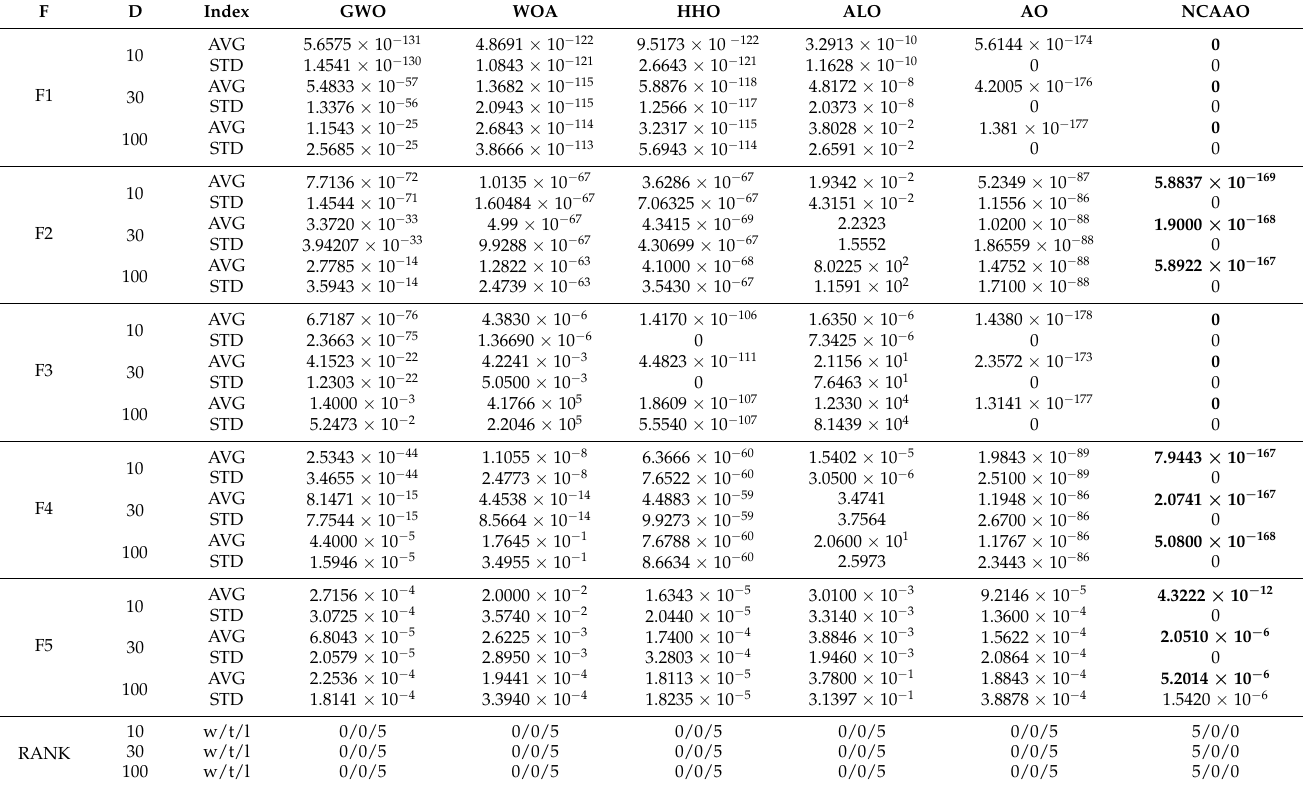
Table 5. The comparison of obtained solutions for unimodal functions.